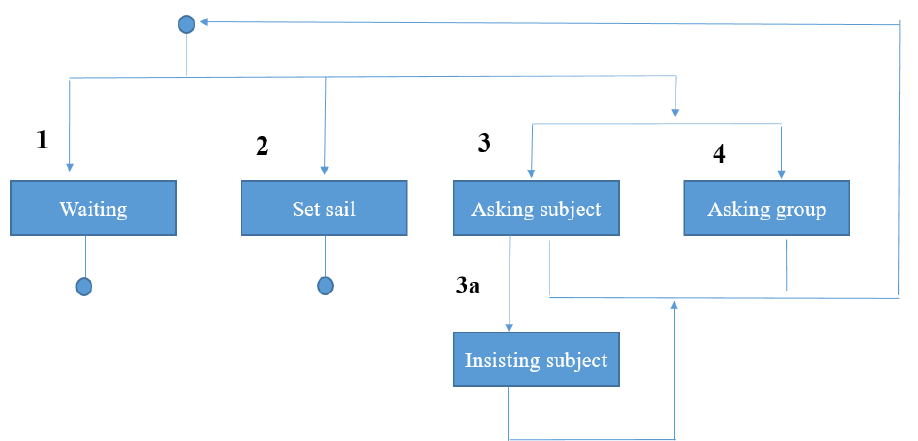
Figure A1. Situation 1—Bad memory. Note. 1 = doing nothing; 2 = execution; 3 and 4 = communica- tion.